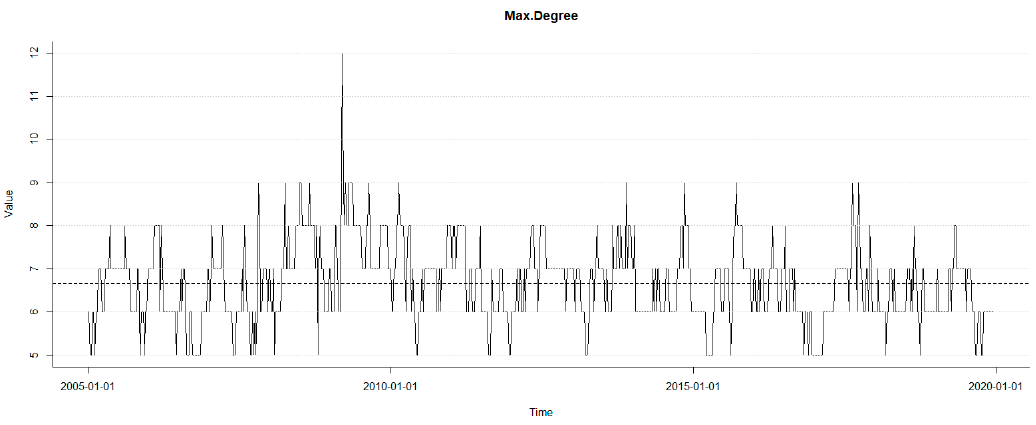
Figure 7. Maximum degree in the period from 7 January 2005 to 20 December 2019. Source: Own